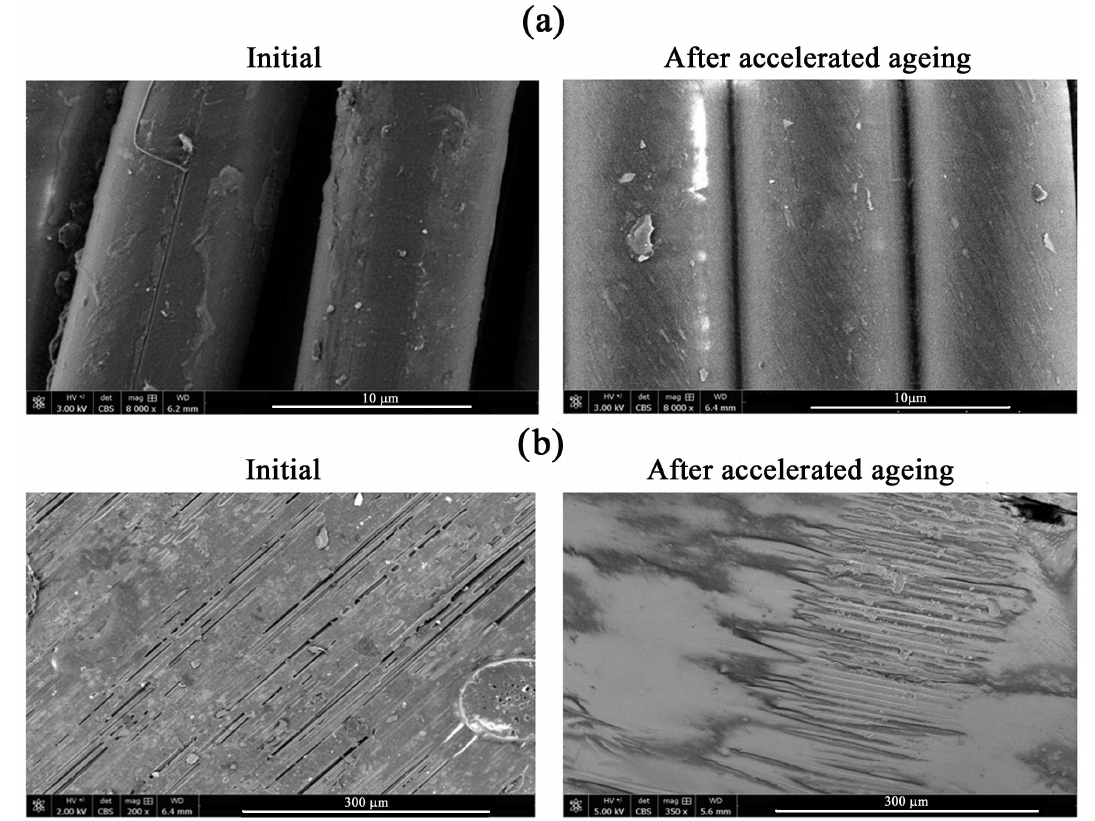
Figure 3. SEM images obtained for sample A ( a ) and sample B ( b ) before and after accelerated ag- ing processes . aging